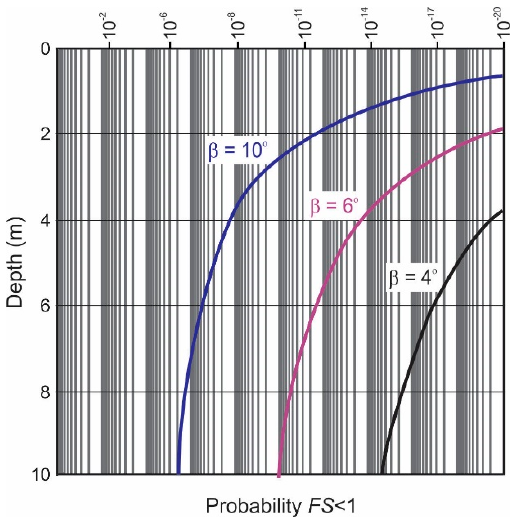
Figure 9. The probability of FS being less than one.